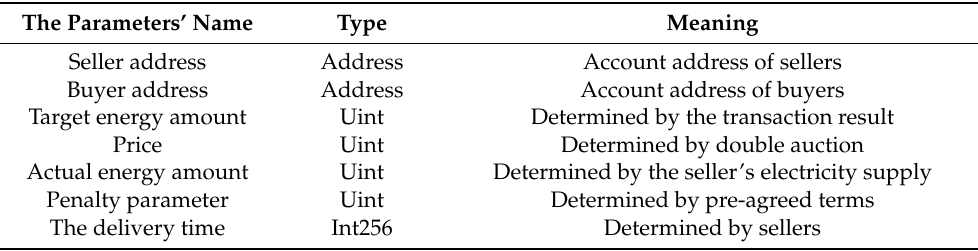
Table 5. Basic elements of a settlement